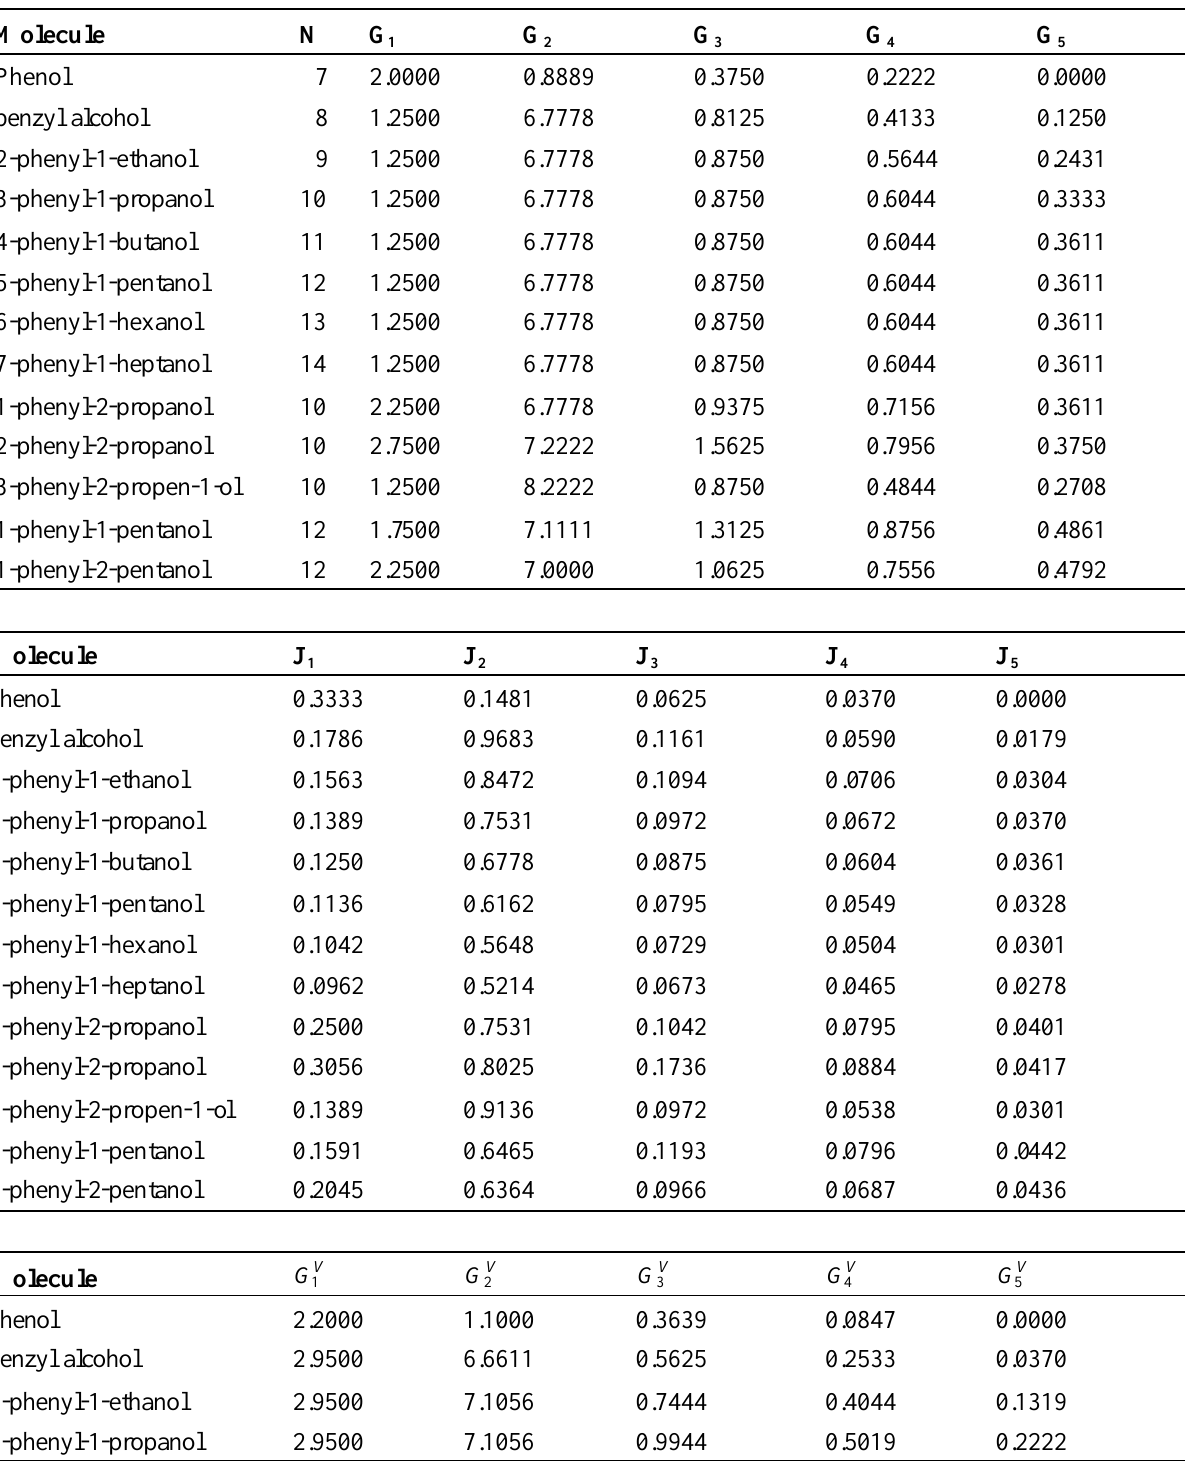
and J charge-transfer indices up to the fifth order for a k k homologous series of phenyl